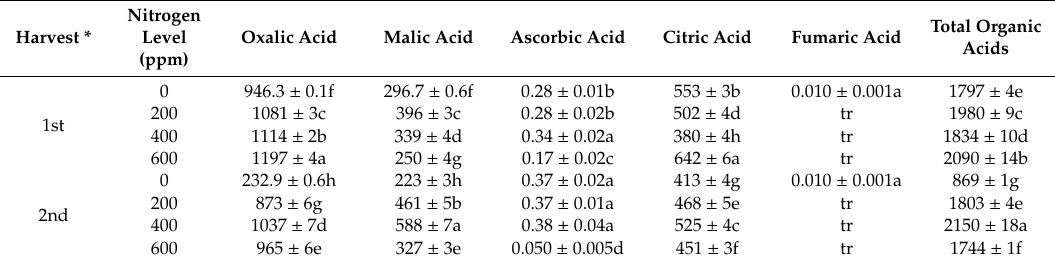
Table 5. Composition in organic acids (mg / 100 g fw) of Centaurea raphanina subsp. mixta plants grown in 2 L pots under greenhouse conditions, in relation to harvesting time (1st and 2nd harvest) and nitrogen level (0–600 ppm) (mean ± SD; n =